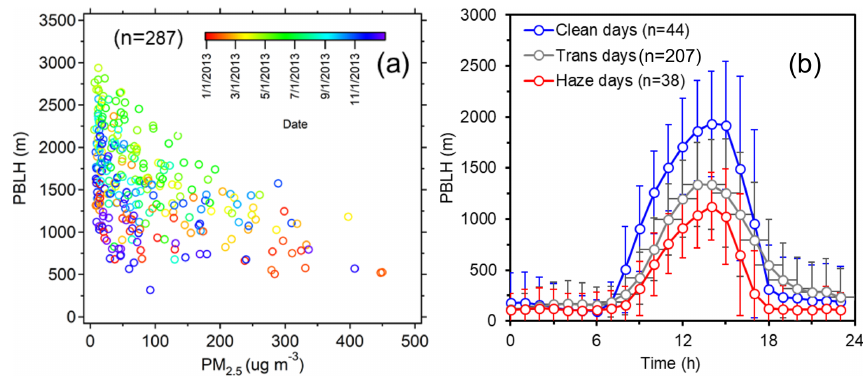
Figure 4. (a) Scatterplot for daily mean PBL height versus PM 2 . 5 concentration and (b) mean diurnal variations of PBL height averaged over clean days (daily mean PM 2 . 5 < 30µgm − 3 ), extremely hazy days (daily mean PM 2 . 5 > 200µgm − 3 ), and transition days (30µgm − 3 < daily mean PM 2 . 5 < 200µgm − 3 ) in 2013 in Beijing, China. n denotes the number of days used for plotting. The vertical lines in (b) denote ± 1 standard deviation. All the precipitation days were filtered out. Table 2. Comparisons between measurements and simulations for aerosol optical properties and surface solar radiation during the two haze episodes (EP1/EP2). Case SSA AOD Max solar radiation flux Accumulated surface solar at surface (Wm − 2 ) radiation (MJm − 2 ) E MAC-BC = 2 . 4 0 . 83 / 0 . 83 3 . 7 / 2 . 1 342 / 403 10 . 1 / 11 . 5 Aged-BC 0 . 87 / 0 . 87 3 . 6 / 2 . 0 326 / 402 9 . 2 / 11 . 3 Observations 0 . 90 a 3 . 5 / 2 . 4 b 480 c / 452 10 . 6 c / 9 .